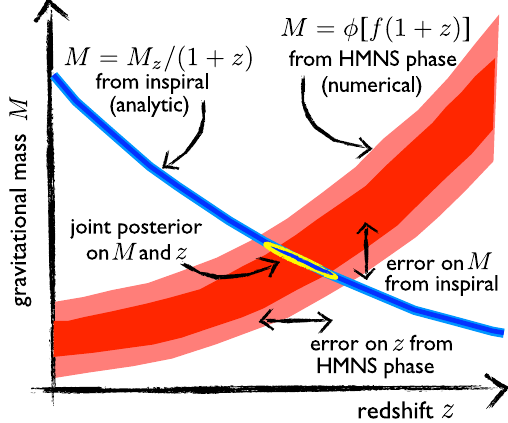
FIG. 1. Illustration of how the mass-redshift degeneracy is broken through the use of information from the inspiral and HMNS stage of a BNS merger event. Information on the redshifted mass as a function of the redshift (blue stripe) can be correlated with complementary information from the spectral properties of the HMNS phase. The overlap will provide a localized range in mass and redshift, breaking the degeneracy.